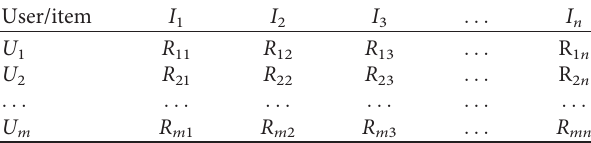
Table 1: User-item scoring matrix.